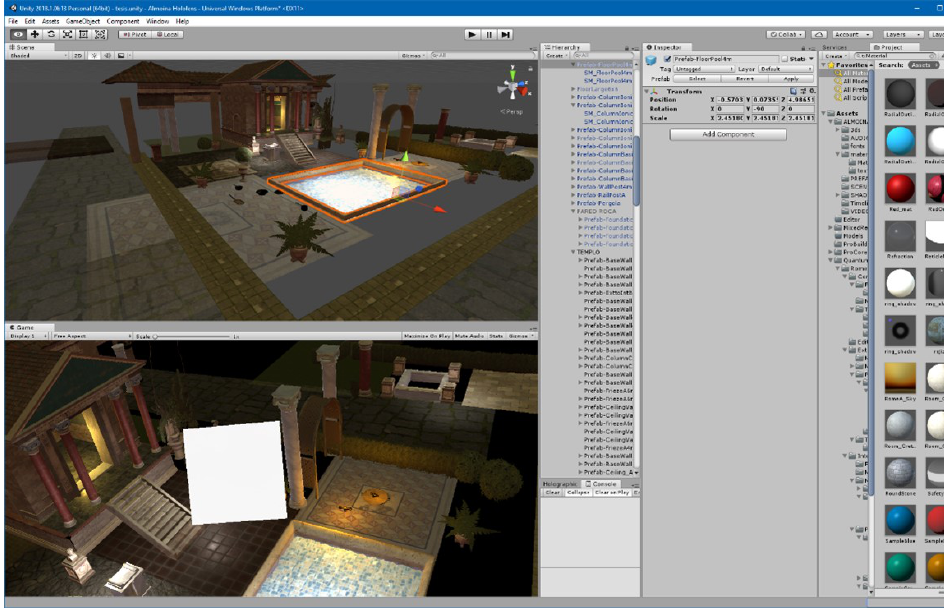
Figure 9. Unity3D video game